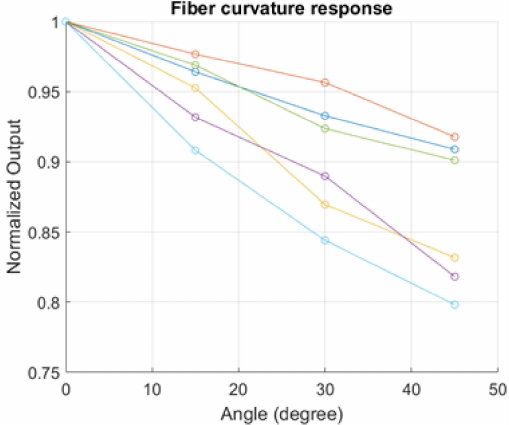
Figure 2. Normalized response to curvature of six sensitive points. Table 1. Average normalized responses and standard deviations at different curvature angles.